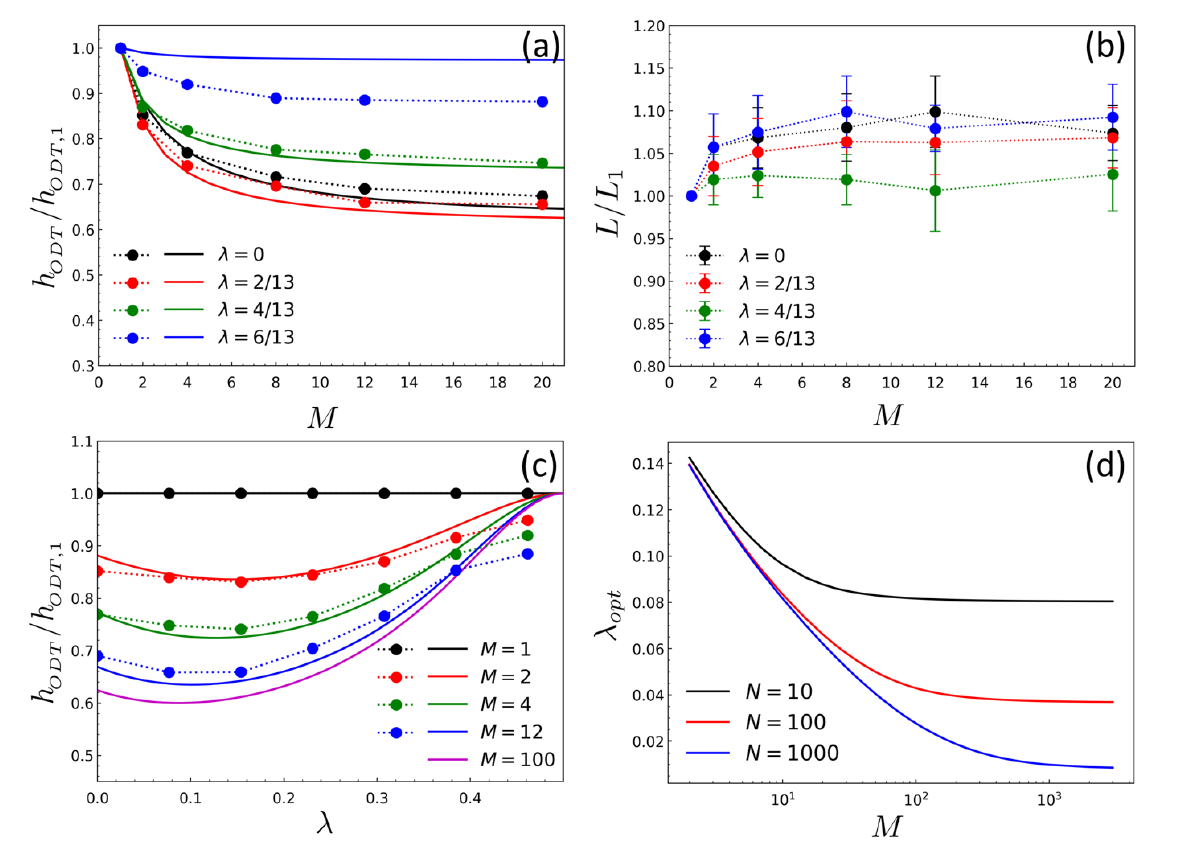
Figure 3. The behavior of ODT and domain spacing of BCPs with various chain topologies: ( a ) The normalized ODT ( h ODT / h ODT,1 ) as a function of the backbone length M for different topology parameter λ , where h ODT,1 is h ODT of diblock ( M = 1); ( b ) the normalized domain spacing ( L / L 1 ) as a function of the backbone length M for different λ , where L 1 represents L at M = 1; ( c ) The normalized ODT as a function of λ for different M ; ( d ) The optimal value of topology parameter ( λ opt ) as a function of M for different N . In ( a – d ), the symbols with dotted lines represent the DPD results and the solid lines represent the RPA results. All computations were obtained for the side chain length of N = 14. The domain spacing shown in ( b ) were obtained at ∆ a / k B T =